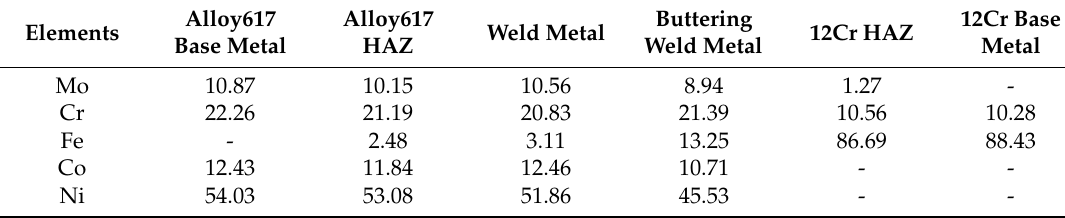
Table 5. Chemical compositions analysis results after PWHT (wt. %).